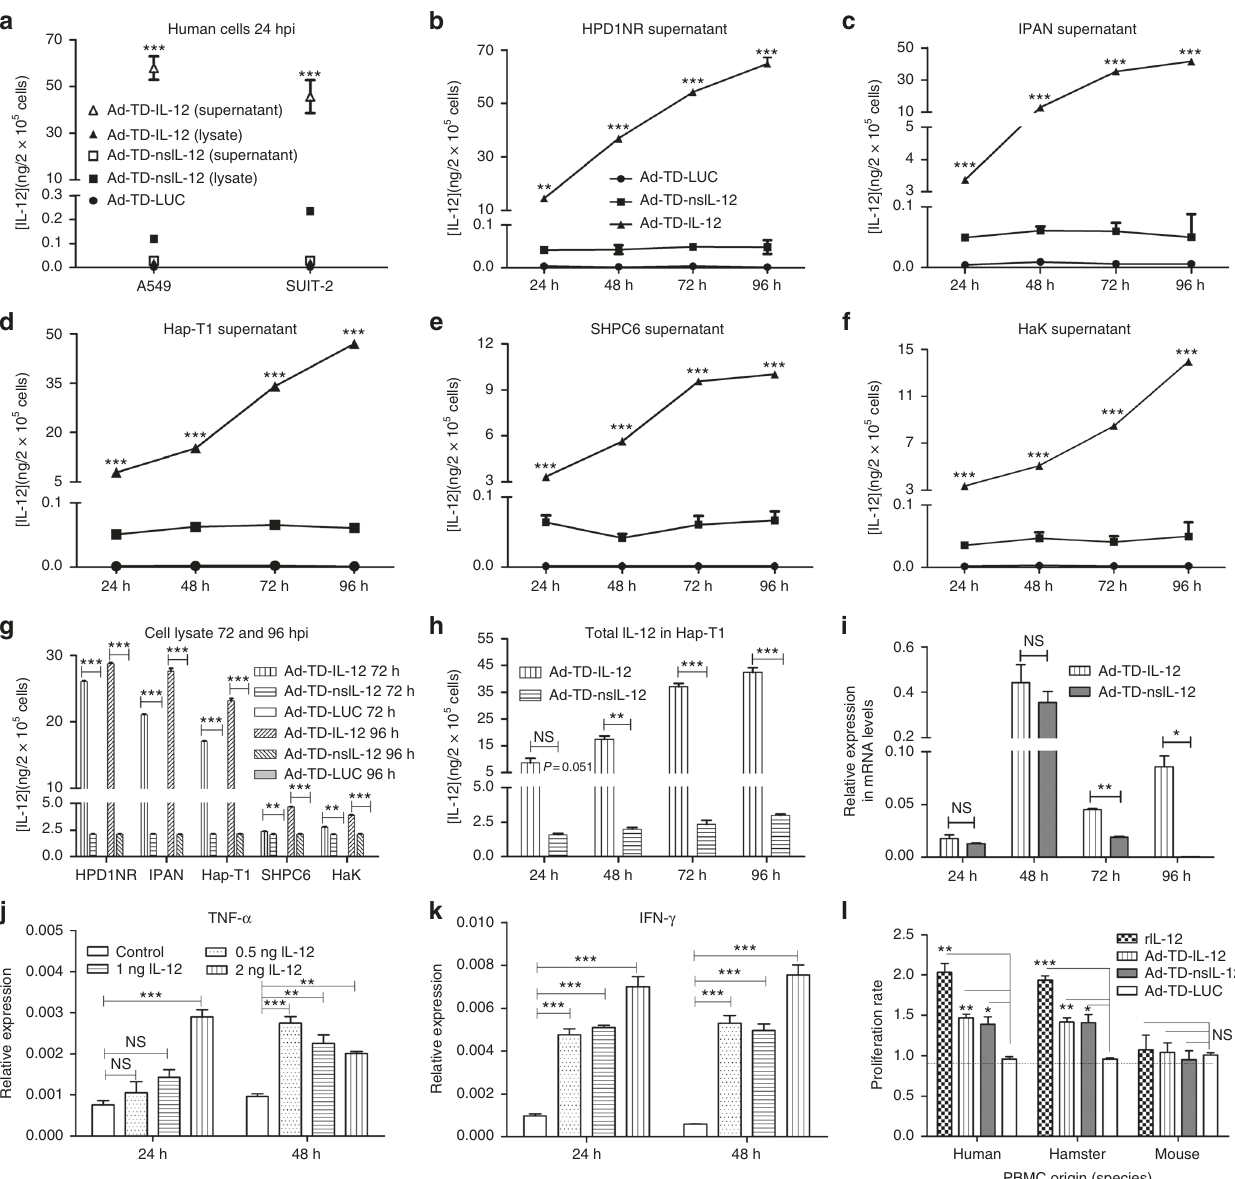
Fig. 3 Ad-TD-nsIL-12 produced IL-12 is functionally active in Syrian hamster cells. a − h To detect IL-12 expression from Ad-TD-IL-12/nsIL-12 in vitro, tumor cells were infected with Ad-TD- IL-12/nsIL-12 or Ad-TD-LUC at an MOI of 5 PFU/cell. Human cancer cells a or Syrian hamster tumor cell supernatants b − f or disrupted cell lysates g were collected every 24 h for 96 h and assayed for IL-12 by ELISA h Intracellular levels of IL-12 were detected in HapT1 cells infected with Ad-TD-IL-12 or Ad-TD-nsIL-12 at an MOI of 5 PFU/cell i mRNA levels of IL-12 were detected in HapT1 cells infected with Ad-TD-IL-12 or Ad- TD-nsIL-12 at an MOI of 5 PFU/cell. mRNA levels relative to β -actin are shown. j , k Recombinant human IL-12 protein (rhIL-12) induced TNF- α j and IFN- γ k expression in hamster splenocytes. mRNA levels relative to β -actin are shown. l Human, hamster, and mouse PBMCs were incubated in the presence of (rhIL-12) or lysate from Hap-T1 cells infected with Ad-TD-IL-12 or Ad-TD-nsIL-12, each at 2 ng/ml, or Ad-TD-LUC infected lysate as a control. Cell proliferation was measured using MTS assay 48 h post-treatment. All experiments were performed in triplicate and the mean and standard error of the mean are shown for each group and compared using an independent t -test. * p < 0.05, ** p < 0.01, *** p < subcutaneous tumors treated once i.t with PBS or virus (1 × 10 9 PFU) (Fig. 7g). At all time-points, treatment with Ad-TD-IL-12, but not Ad-TD-nsIL-12 resulted in signi fi cant increases in CD3+ CD4 − (CD8+) populations in the spleen. Ad-TD-nsIL-12 treat- ment only resulted in a transient increase in CD3+ CD4+ and CD3+ CD4 − (CD8+) populations in local draining lymph nodes but splenic numbers were unchanged compared to the control virus, suggesting that anti-tumor ef fi cacy of nsIL-12 treatment depends more on alteration of T-cell function than alterations of total numbers of circulating lymphocytes (Fig. 7g).